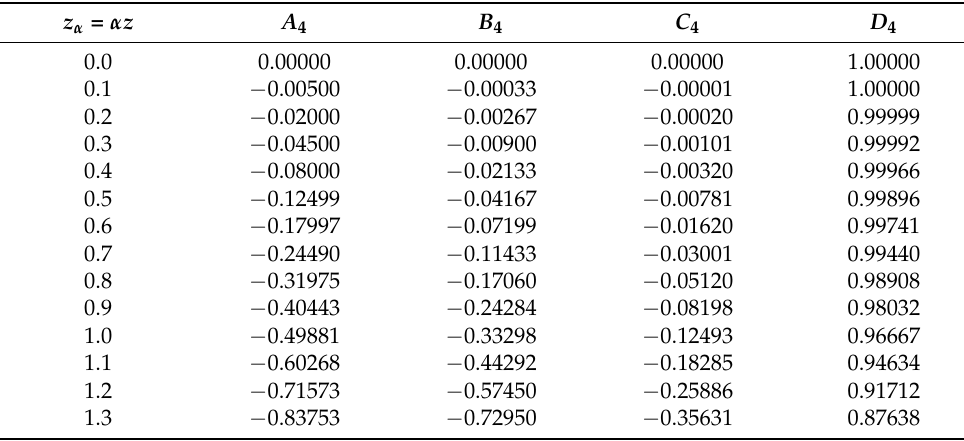
Table A4. Dimensionless coefficient of pile responses ( A 4 , B 4 , C 4 , and D 4